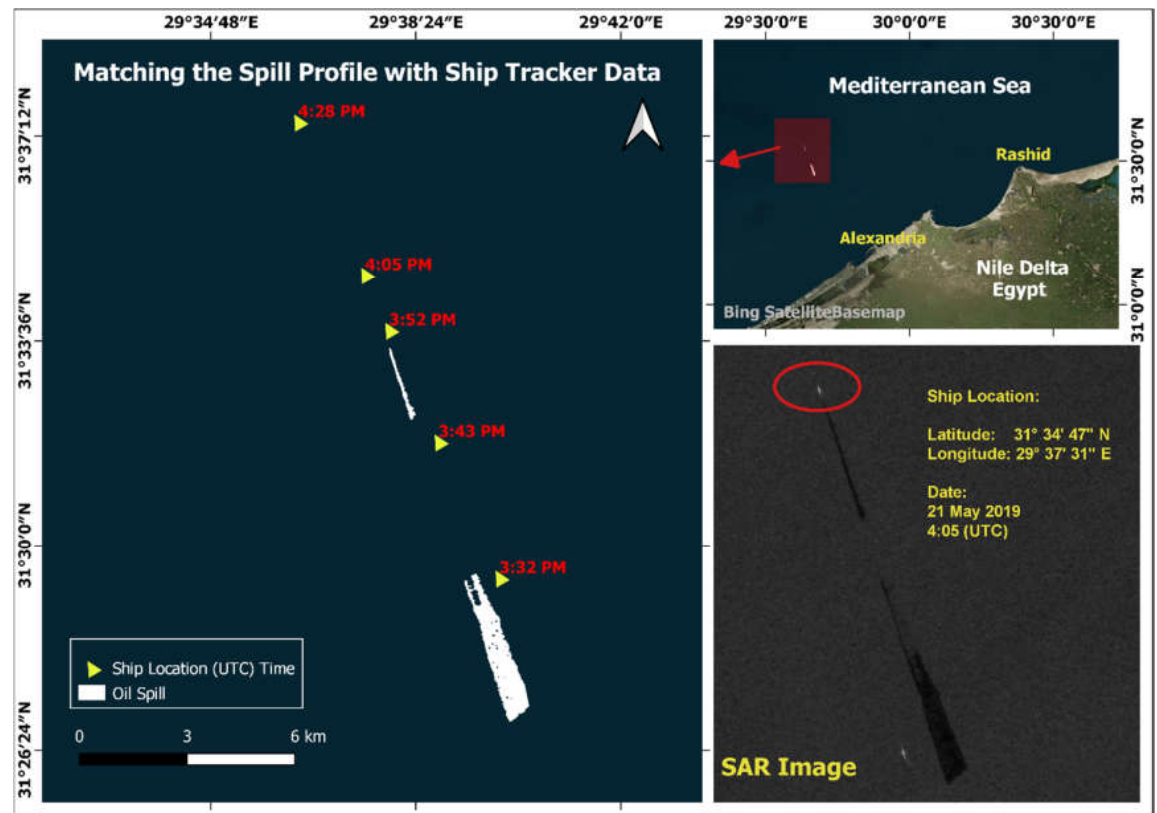
Figure 10. Inter-correlation between longitudinal oil spill case detected by the model near Alexandria City on 21 May 2019 @ 4:05 UTC and the location and direction of the movement of a maritime ship. This enabled the identification of the source of the pollution as the ship.